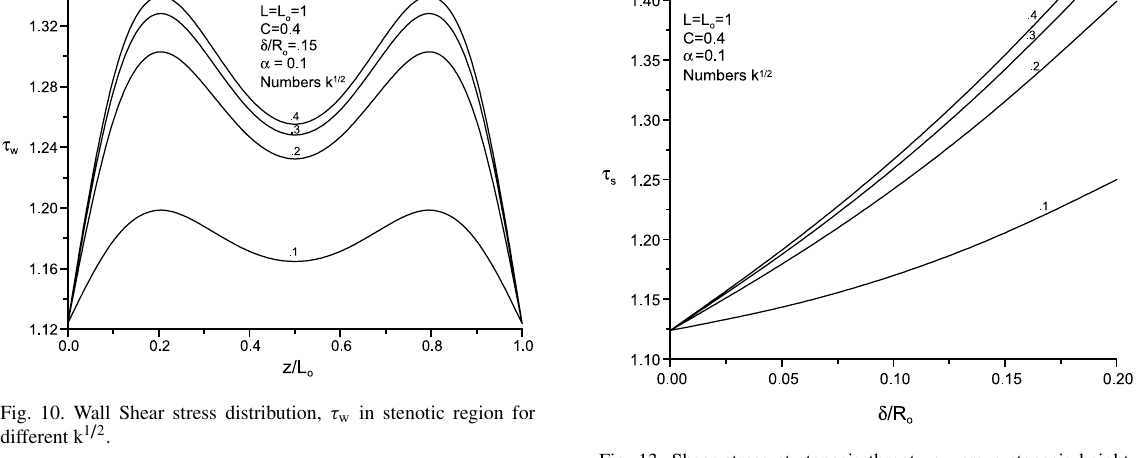
Fig. 13. Shear stress at stenosis throat, τ s versus stenosis height, δ/ R 1 / 2 . o for different k